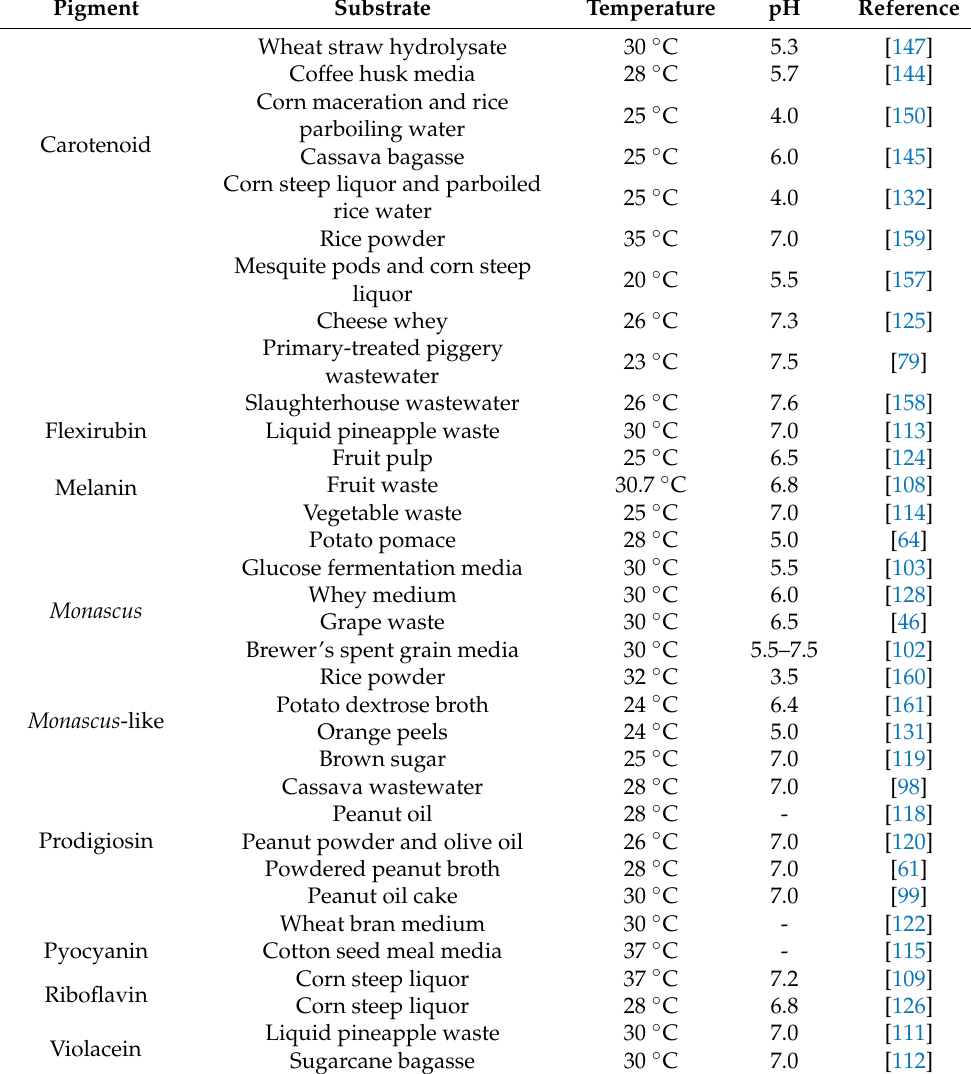
Table 3. Culture conditions set along with various agro-waste to produce different microbial pigments in submerged fermentation. Readers may refer to the respective reference for more details about the concentration of each substrate used in submerged